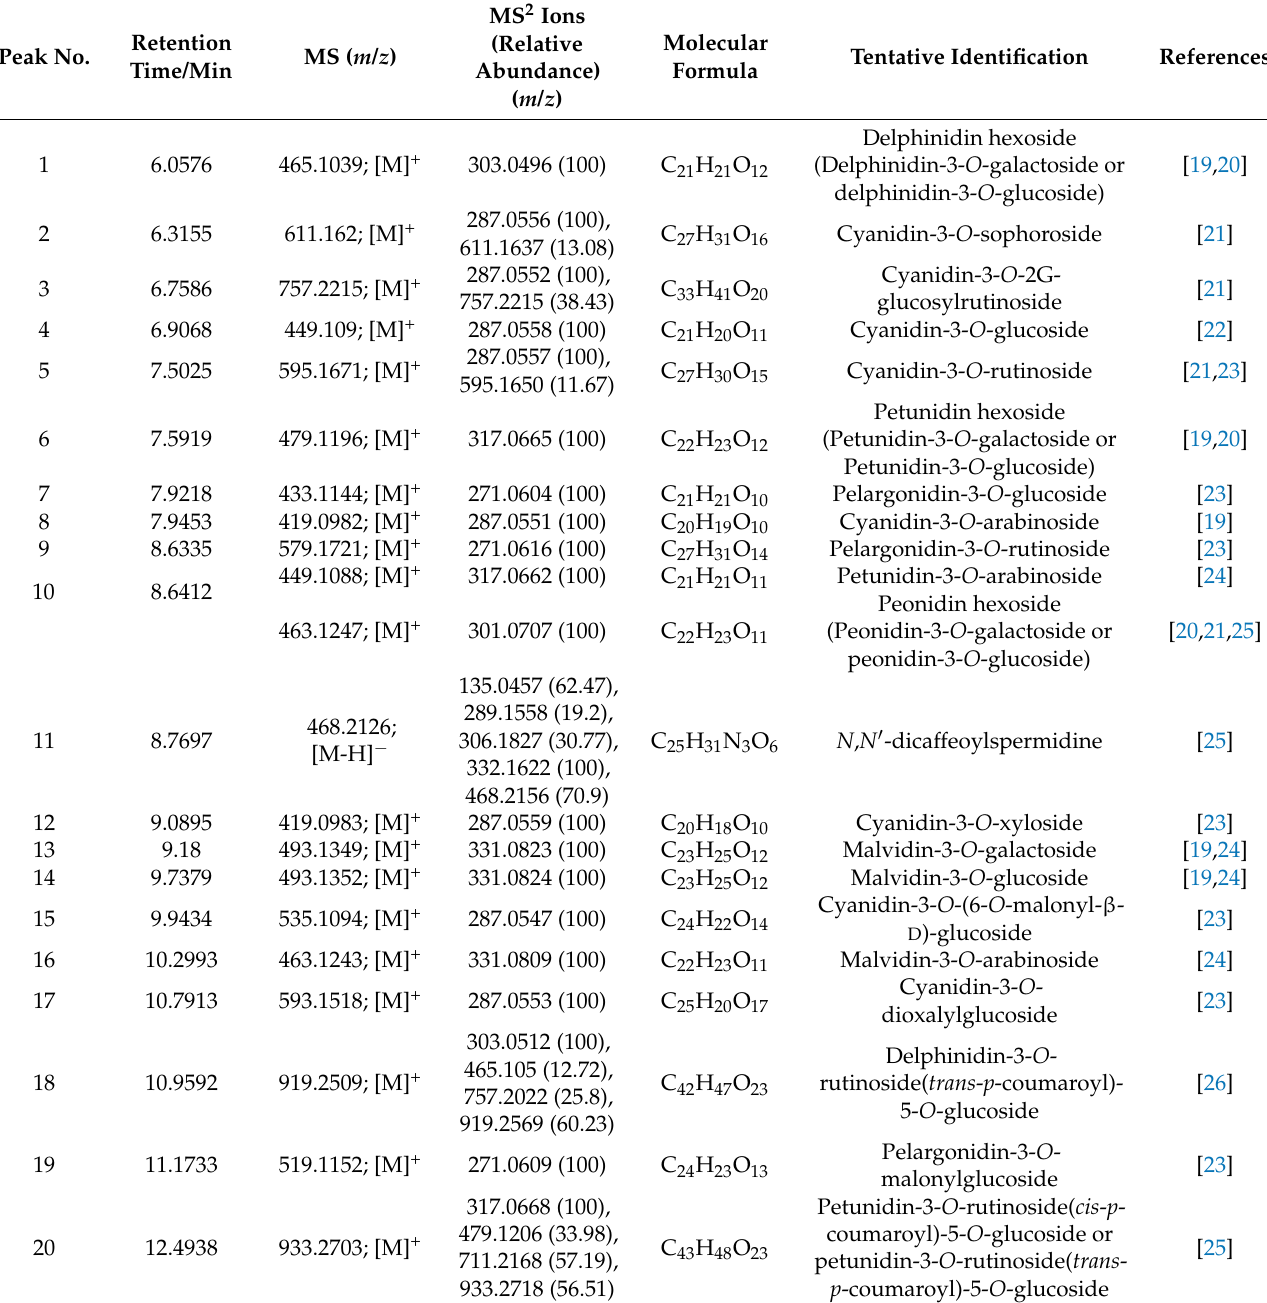
Table 1. Identification of anthocyanins in different kinds of berries by UPLC-Triple-TOF/MS.